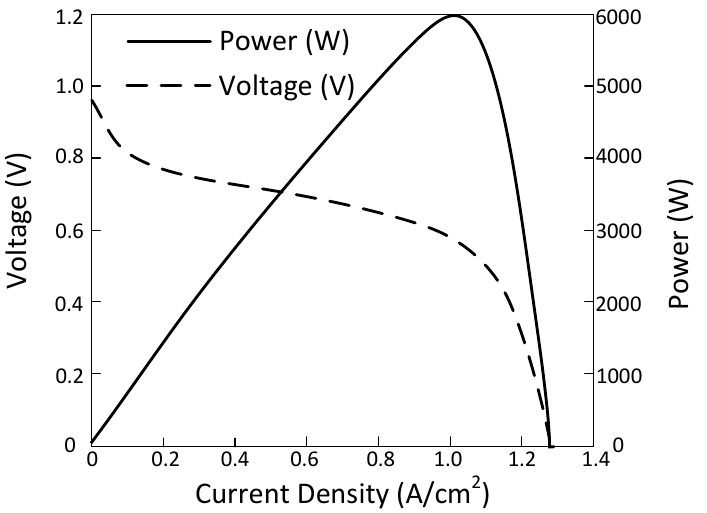
Figure 1. External characteristics of PEMFC.